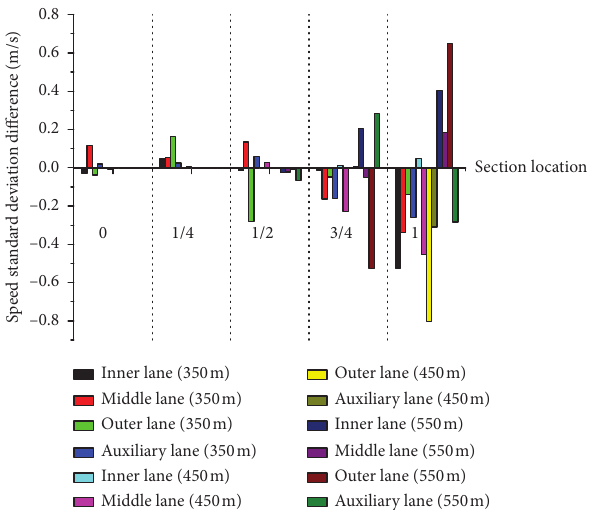
Figure 10: The acceleration of average absolute value difference between the optimized method and the original